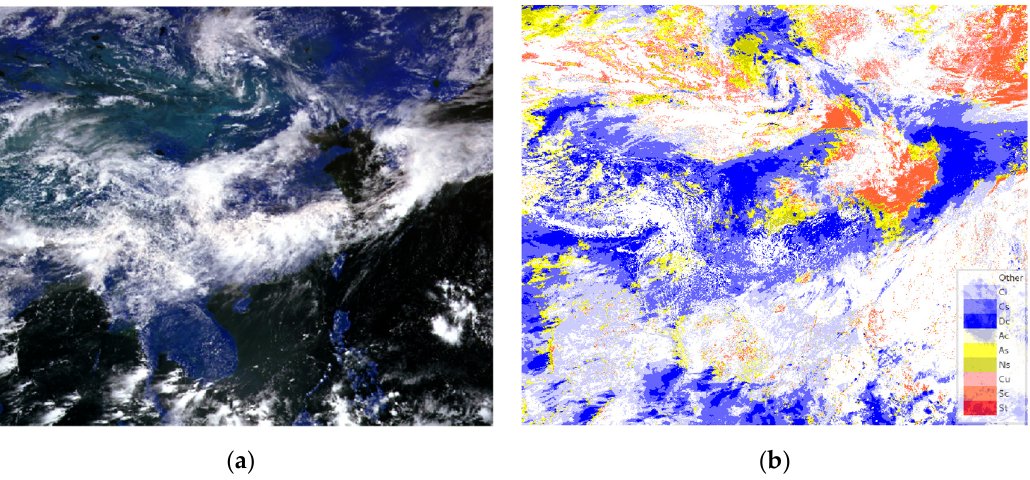
Figure 3. CRMSCD visualization results: ( a ) FY-4A images at 4:30 on July 10, 2020; ( b ) Himawari-8 labels at 4:30 on July 10, 2020. The color corresponding to the label value is located in the lower right corner of ( b ).